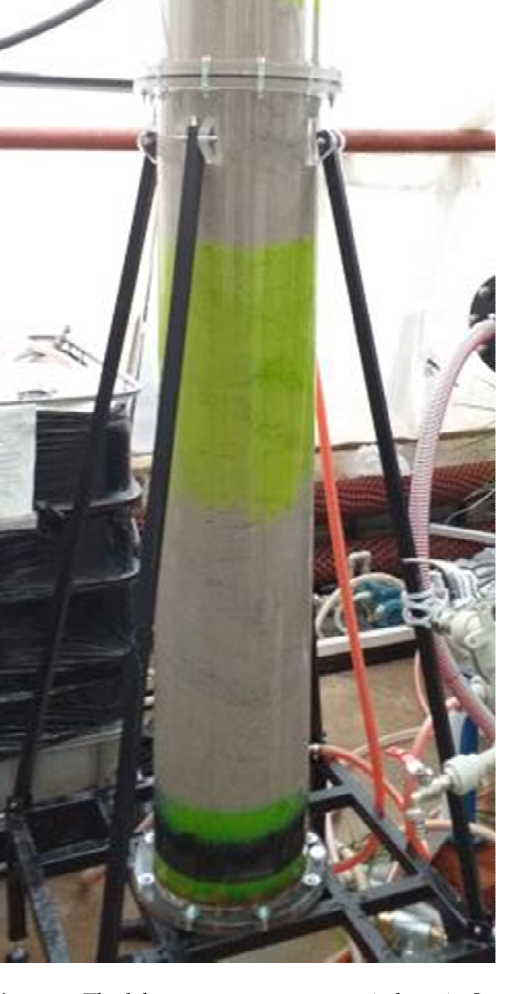
Figure 7. The laboratory tracer test carried out in Scenario C visually indicated the measuring area of the INV-FLOW apparatus.